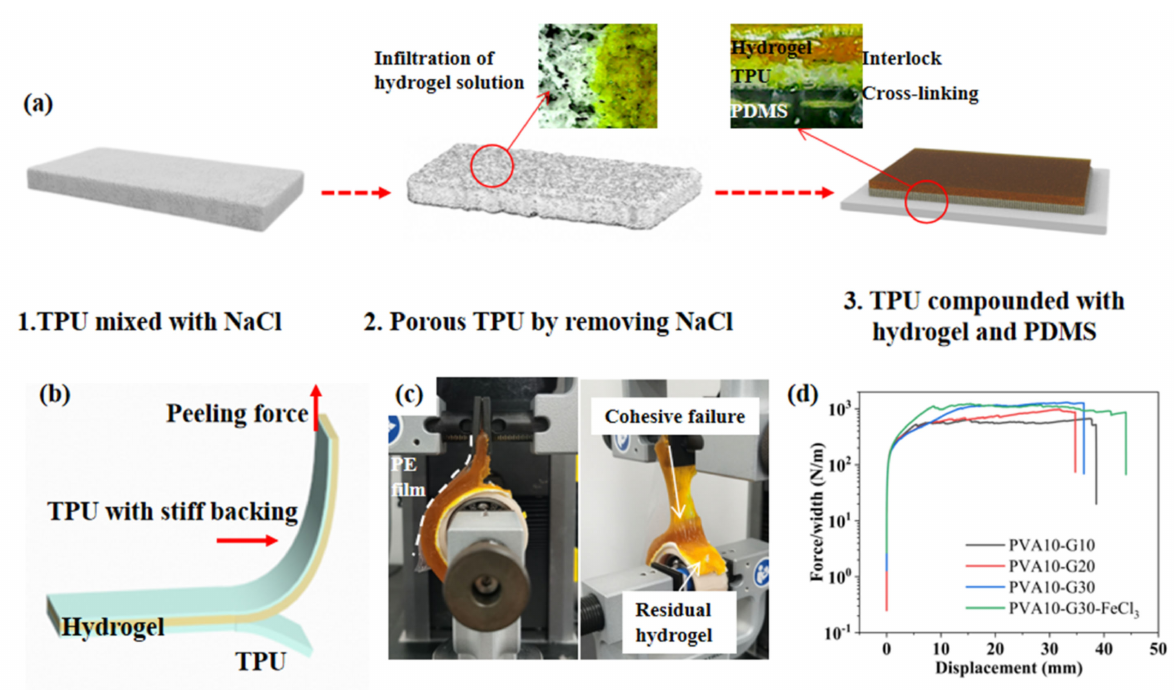
Figure 4. ( a ) The schematic diagram of the preparation of hydrogel-TPU-PDMS hybrid. ( b ) The schematic diagram of the 90 ◦ —peeling test. A stiff backing is introduced to prevent elongation of the hydrogel sheet along the peeling direction. ( c ) Photos of the hydrogel-TPU interface during the peeling test. The tough hydrogel undergoes a cohesive failure during the peeling test, leaving a thin residual layer of hydrogel on the TPU substrates. ( d ) The measured peeling forces per width of the hydrogel sheets for hydrogel-TPU